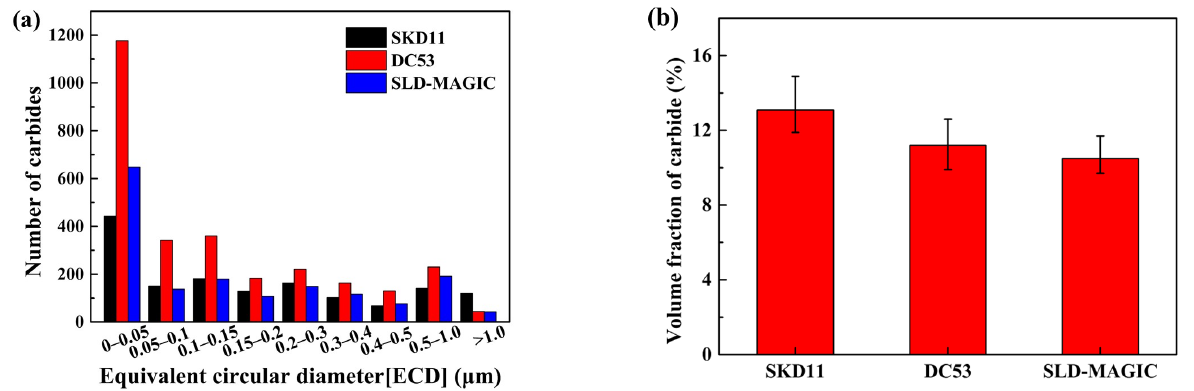
Figure 4. ( a ) Particle sizes distribution; ( b ) volume fraction of carbides of tempered SKD11, DC53 and SLD-MAGIC.